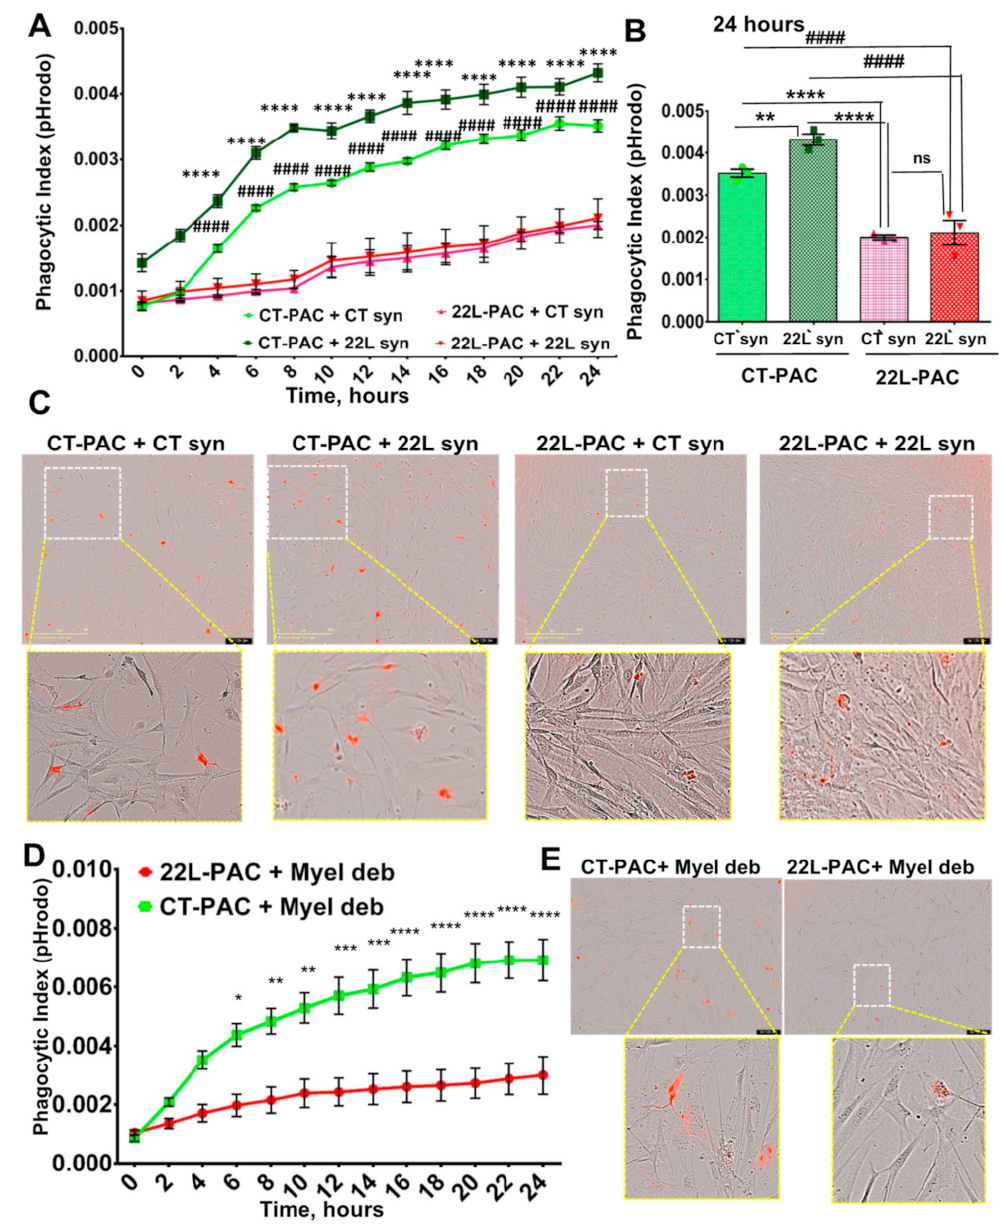
Figure 6. Live-cell imaging of phagocytic activity of PACs from 22L-infected mice. ( A ) Real-time, live-cell imaging of uptake of 22L-syn or CT-syn by 22L-PACs or CT-PACs monitored by pHrodo Red fluorescence assay over the time period of 24 h. ( B ) Analysis of phagocytic indexes measured by live-cell pHrodo Red fluorescence assay at 24 h time point. ( C ) Representative overlaps of phase-contrast and fluorescence images of 22L-PACs and CT-PACs exposed to 22L-syn or CT-syn. ( D ) Real-time, live-cell imaging of uptake of myelin debris by 22L-PACs and CT-PACs over the time period of 24 h monitored by pHrodo Red fluorescence assay. ( E ) Representative overlaps of phase-contrast and fluorescence images of 22L-PACs and CT-PACs exposed to myelin debris. For all live-cell imaging assays, n = 3 22L-PAC or CT-PAC cultures, each isolated from an individual animal and cultured in three wells. For each well, four images were automatically acquired every 2 h. n = 3 independent isolations from individual animals for each 22L-syn, CT-syn, or myelin debris. Data presented as mean ± SEM. * p ≤ 0.05, ** p ≤ 0.01, *** p ≤ 0.00,1 and **** or #### p ≤ 0.0001, and ‘ns’ non-significant by a two-way ANOVA followed by Tukey’s